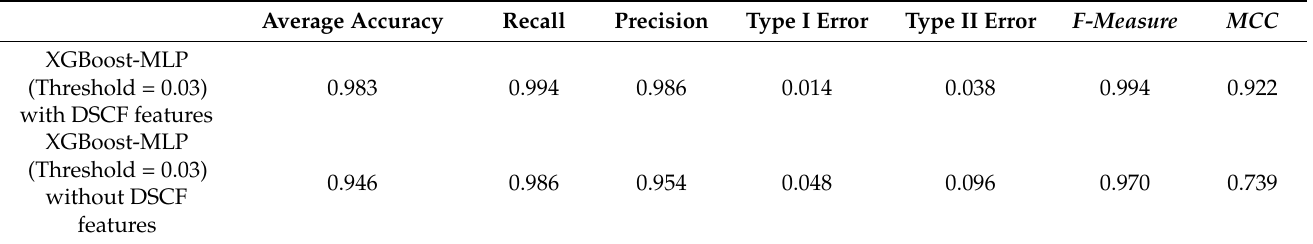
Table 6. Comparison of XGBoost-MLP with/without digital SCF